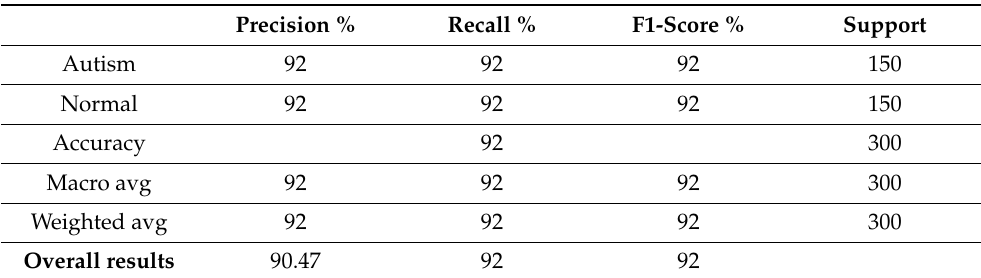
Table 2. Results of MobileNet model.